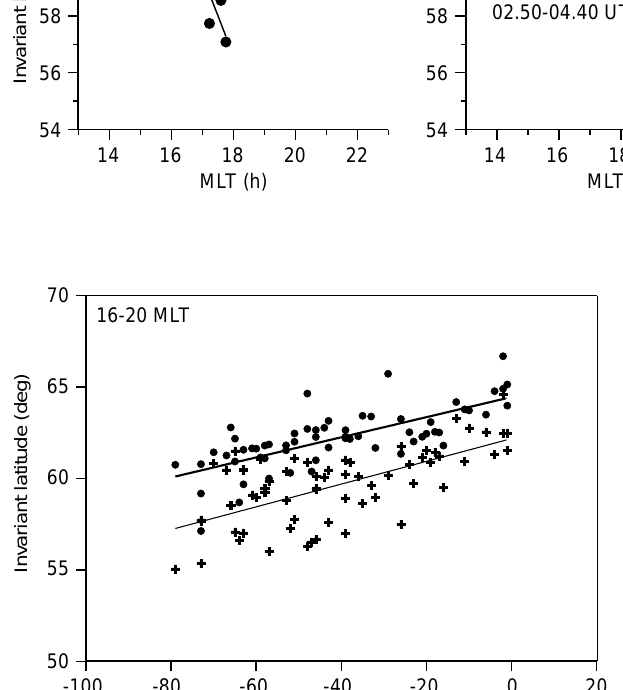
Fig. 5. Dependence of the cli(cid:128) latitude on MLT for longitudinally spaced satellite passes for prolonged time intervals. Measurements related to di(cid:128)erent intervals are marked by the di(cid:128)erent symbols